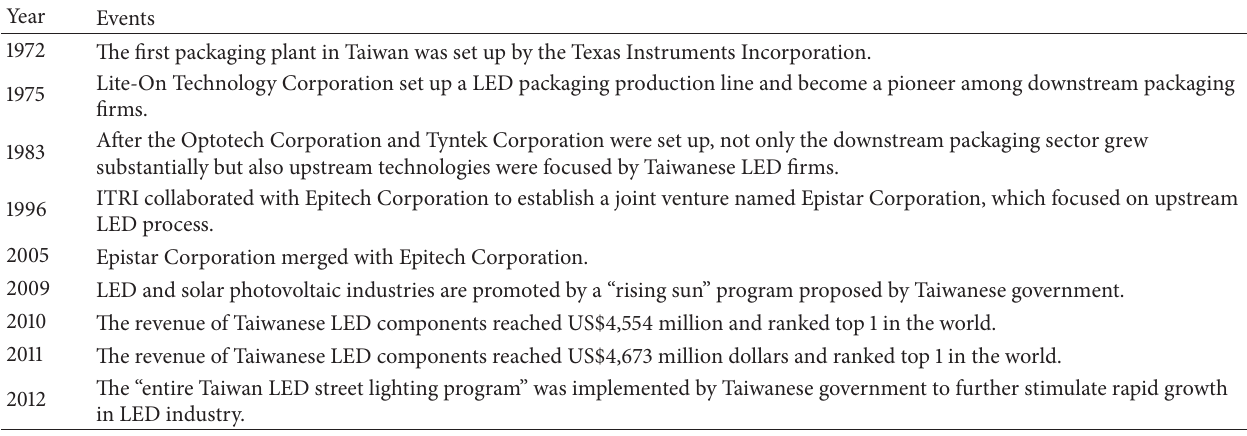
Table 5: The history of Taiwan LED